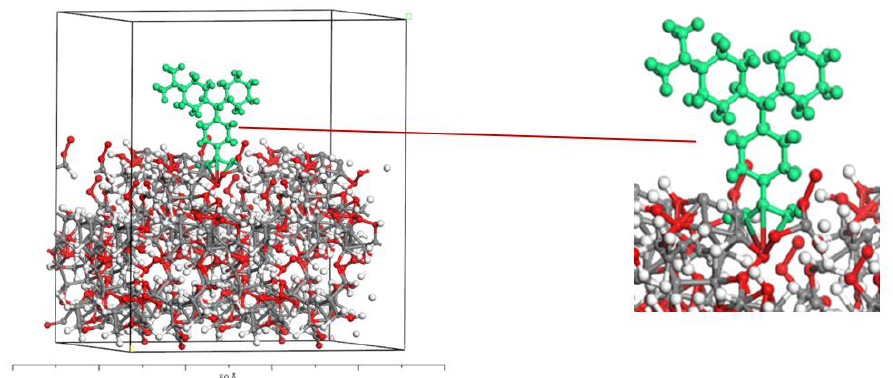
Figure 19. DG fiber (−1 1 0) surface and single MG molecular simulation (structure B) adsorption configuration.